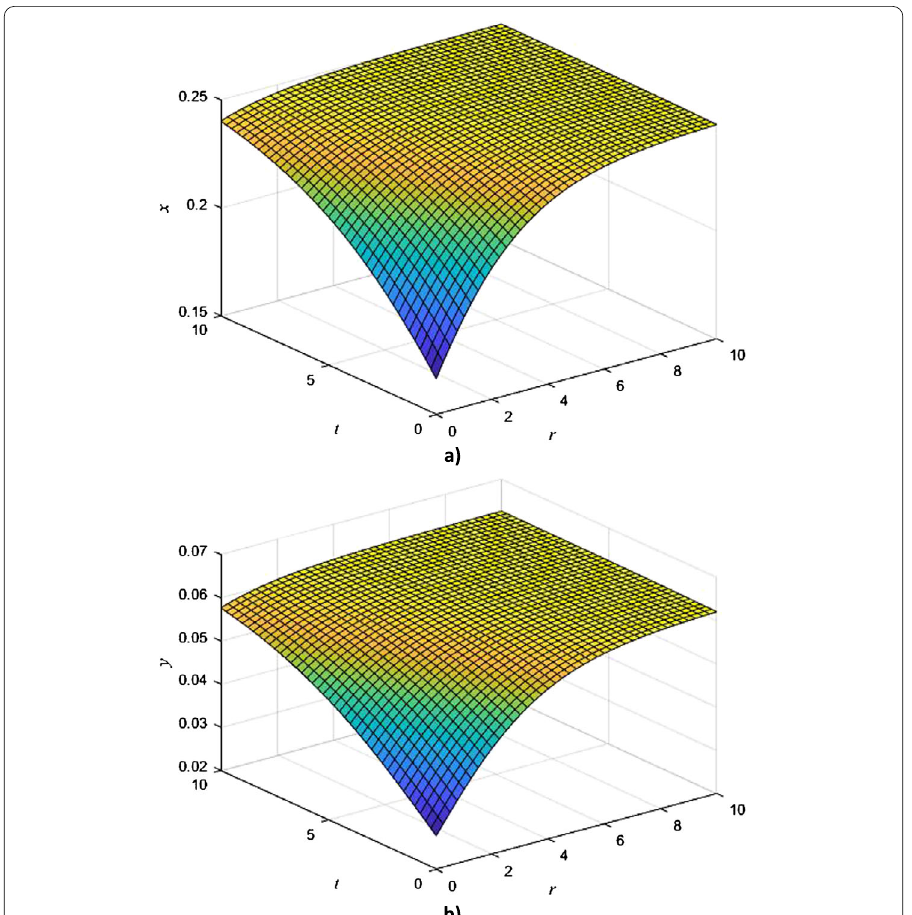
Figure 4 Three-dimensional illustrations. Three-dimensional plots of traveling wave solutions of ( a ) fish density x , and ( b ) recruitment intensity y , as functions of spatial position r for t .